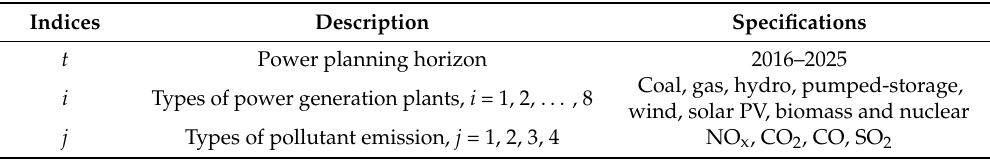
Table 1. List of indices.